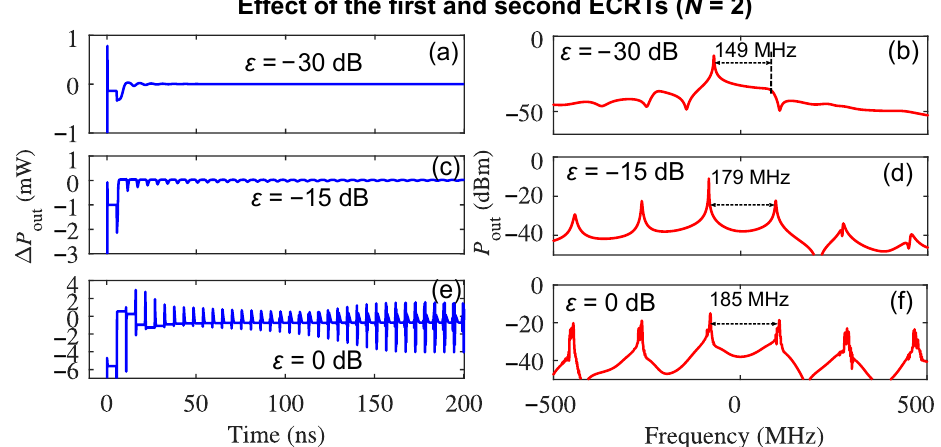
Figure 3. The cumulative effects of the first and second ECRTs on the self-pulsation dynamics in a THz QCL under optical feedback: ( a , c , e ) are the AC component of the emission power ∆ P out when ε is − 30 dB, − 15 dB, and 0 dB, respectively; ( b , d , f ) are the emission spectrum (offset to the emission frequency 2.752 THz) when ε is − 30 dB, − 15 dB, and 0 dB, respectively.